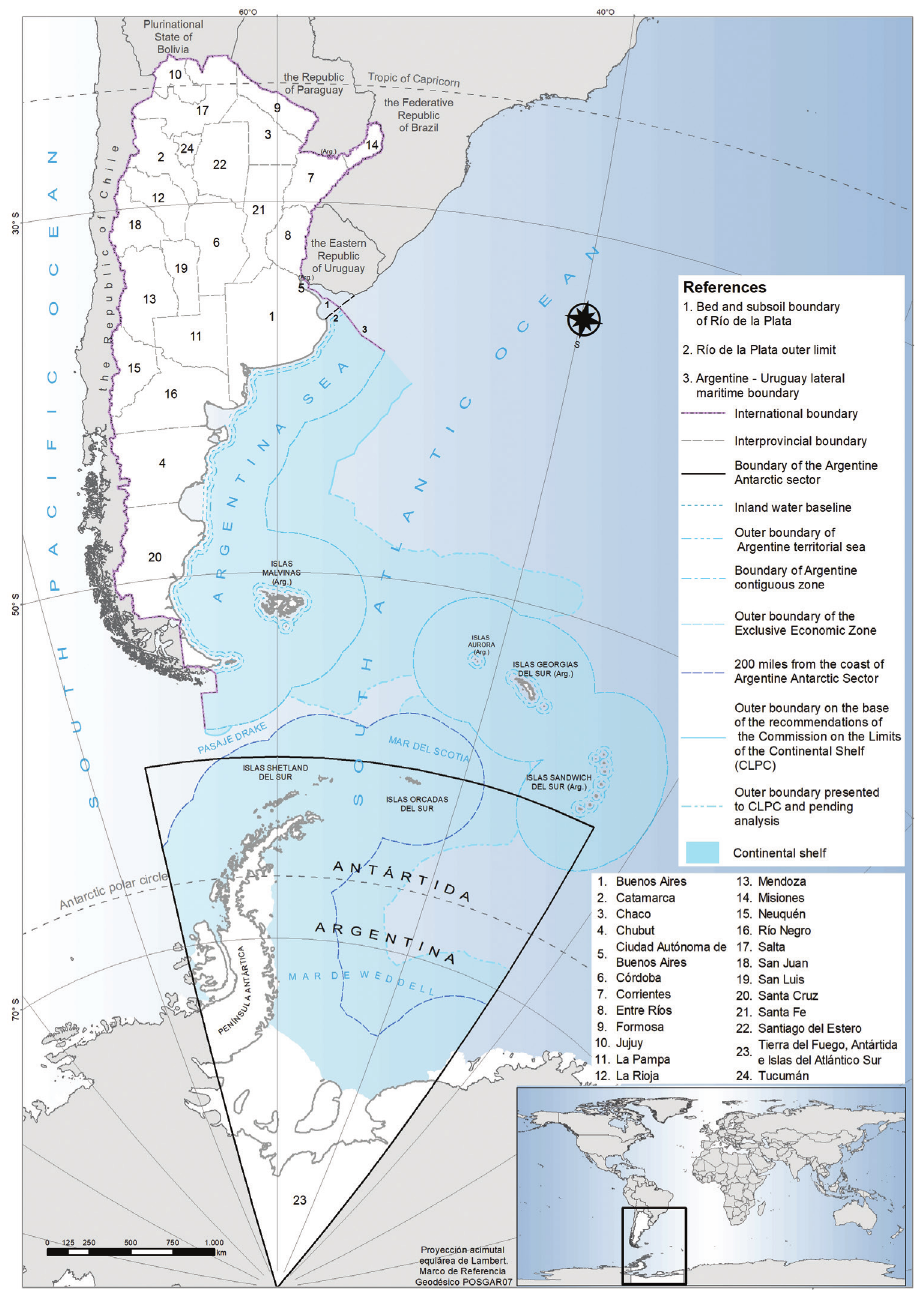
Figure 1. Political map of Argentina. International and national boundaries, including terrestrial and maritime, are indicated. Each of the 23 provinces and the autonomous city of Buenos Aires are depicted. Source of spatial information: National Geographic Institute (IGN